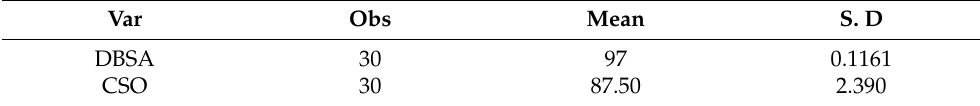
Table 19. Z-test descriptive statistics.